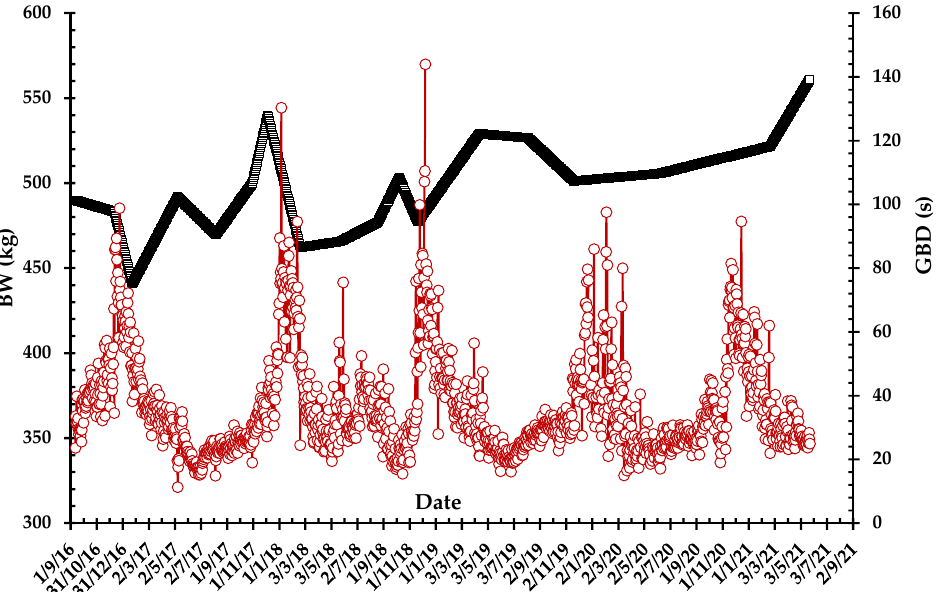
Figure 8. Study cows’ grazing bout duration (GBD, s, o), and its relationship to cows’ live BW (kg), □ . Dates are given as day/month/year. Table 1. Validation of ADG (g/d) as estimated by HMS, compare to its calculation from the BCS changes of the cows with collars, and to the direct cow measurement. Data from five measurement periods that ended at weaning. The last row represents the ADG estimated by the HMS minus ADG calculated from the BCS changes.